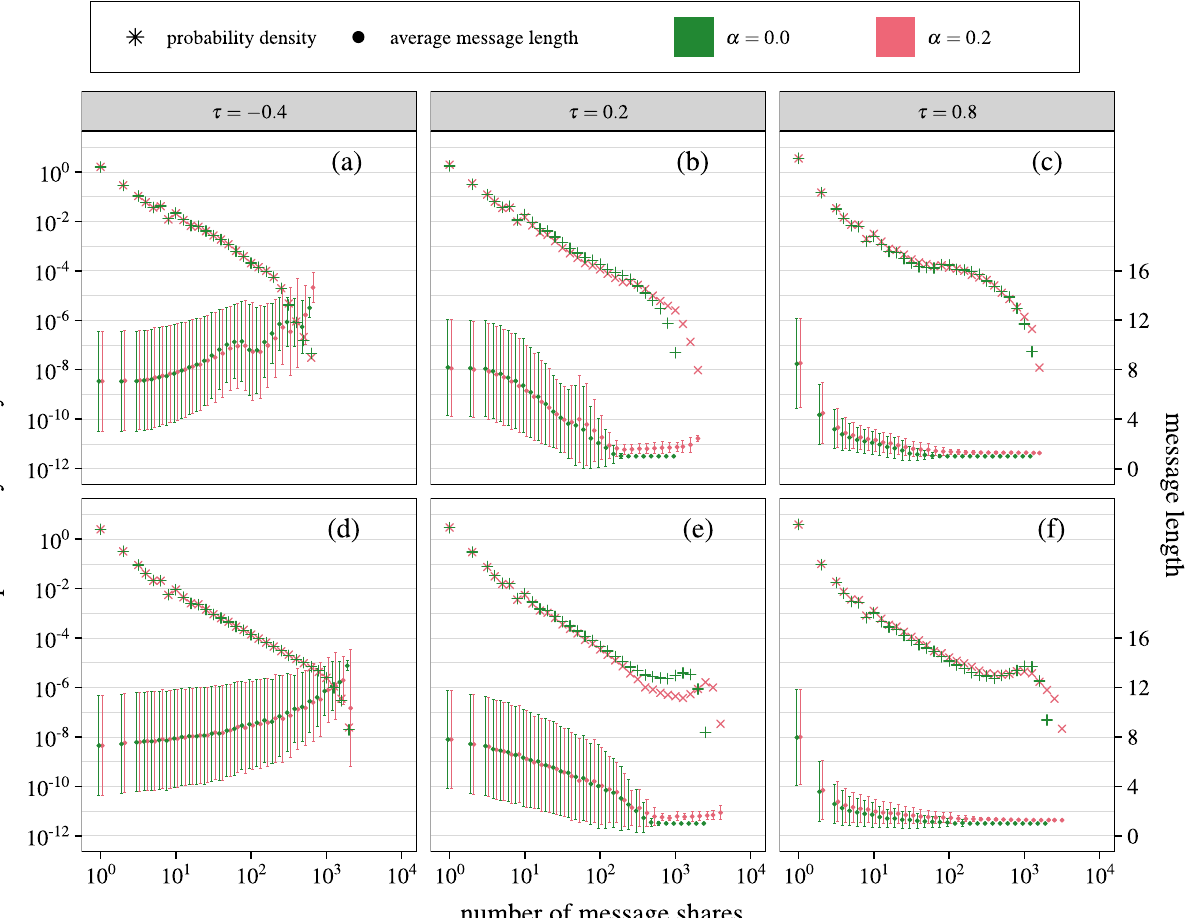
Figure 4. The model behaves similarly in real networks as it does in synthetic networks, although there are visible differences for Facebook ego-network. The figure presents the influence of user selectivity τ and message adaptivity α on the popularity and average length of messages propagating in real networks. Panels ( a )–( c ) shows message spreading for Facebook users network, N = 4039 and � k � = 43.69 . while panels ( d )–( f ) for English Twich users N = 7126 , � k � = 9.91 (see section “Datasets” for dataset details). Number of time steps is equal to 1, 000, 000 in every case. Columns correspond to different selectivity τ = − 0.4 , 0.2, 0.8, green symbols are for simulations without adaptivity ( α = 0 ) while red are with adaptivity ( α = 0.2